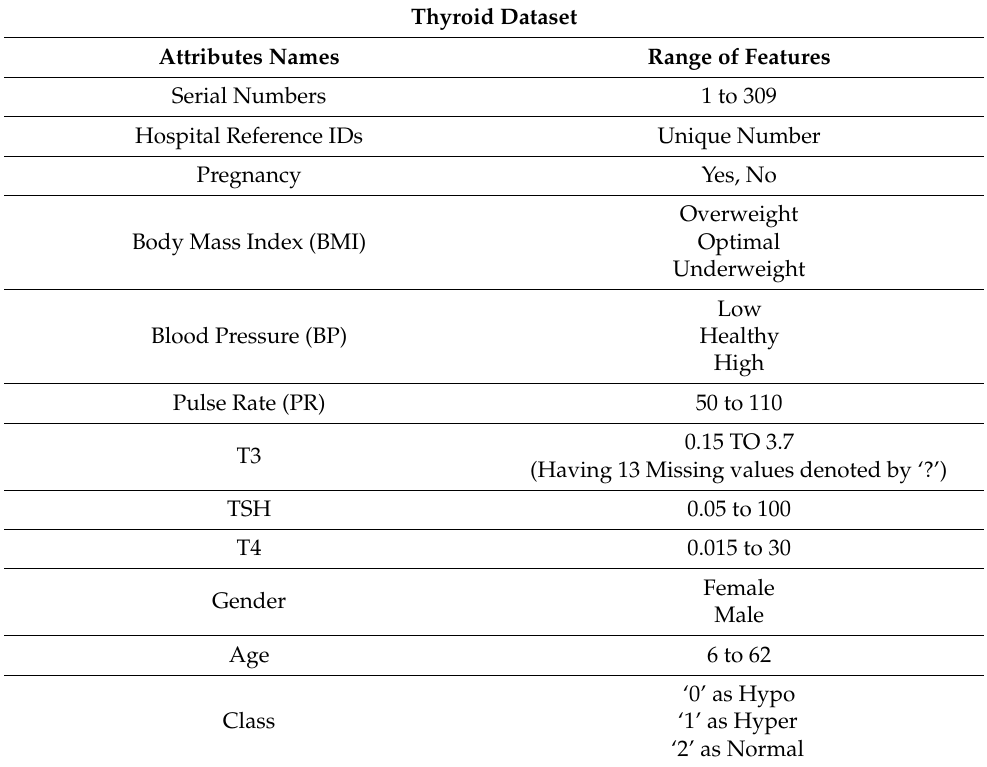
Table 1. Details about the dataset related to thyroid disorders from the registered